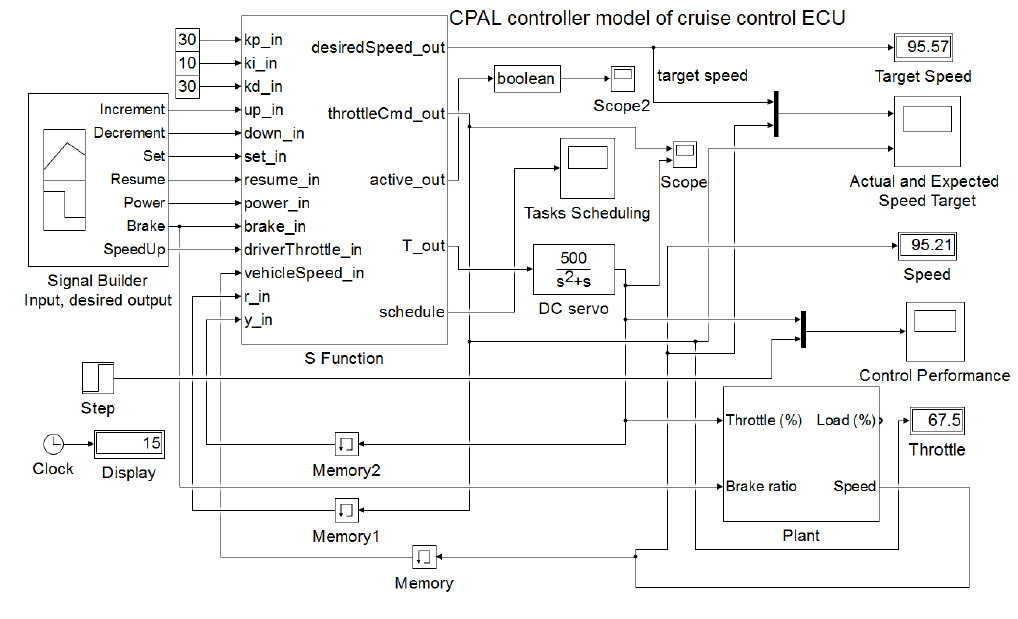
Figure 6. Illustration of a CPAL controller in Simulink. Here, the CPAL model controls the servo which in turn actuates the engine throttle. The controller task is executed with simulated input-to-output